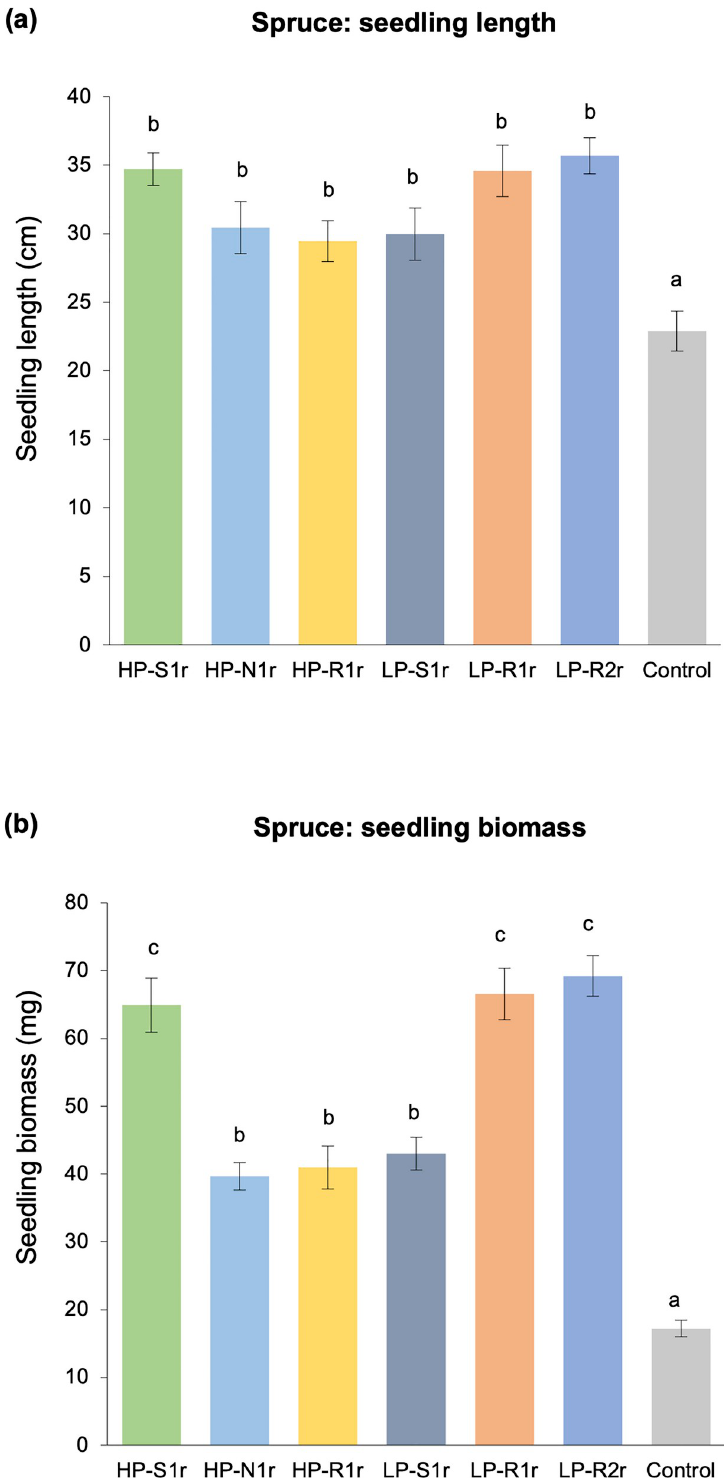
Fig 2. Mean values of (a) length and (b) biomass of 540-day old hybrid white spruce seedlings subjected to six bacteria-inoculated ( Caballeronia sordidicola HP-S1r, Pseudomonas frederiksbergensis HP-N1r, Phyllobacterium myrsinacearum HP-R1r, Pseudomonas mandelii LP-S1r, Paraburkholderia phytofirmans LP-R1r and Caballeronia udeis LP-R2r) and one non-inoculated control treatments. Error bars represent standard errors of the mean (n = 10 seedlings per treatment) and bars with different letters are significantly different (P <